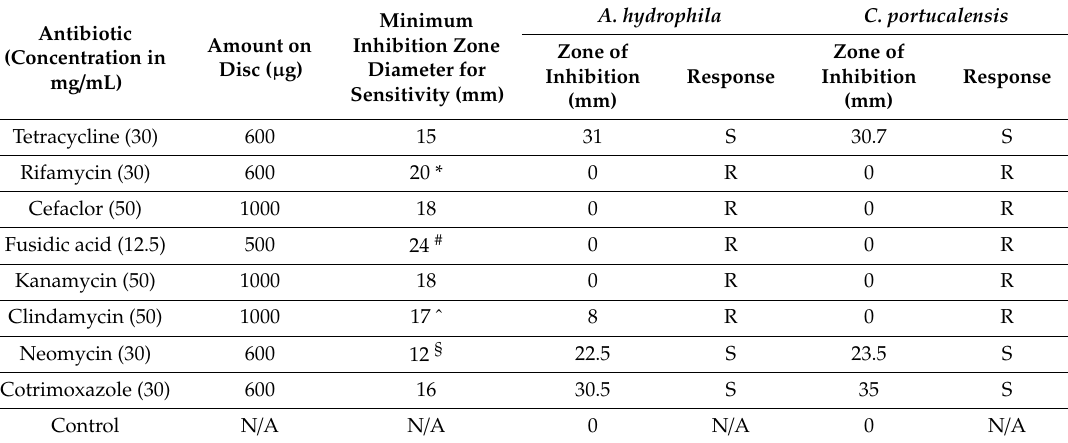
Table 2. ‘Stock concentration’ susceptibility tests using blank BD di ff usion discs spotted with stock concentrations of antibiotics for A. hydrophila and C. portucalensis grown on tryptic soy agar (TSA). The minimum zone of inhibition diameters are based on the values recommended by the CLSI for Enterobacteriaceae [81]. * denotes recommended for Rifampin by the CLSI for Enterobacter spp. # denotes EUCAST breakpoint for Staphylococcus spp. ˆ denotes EUCAST breakpoint for Streptococcus groups. § denotes EUCAST breakpoint for Enterobacterales. Cotrimoxazole = trimethoprim with sulfamethoxazole (ratio 1:5). The EUCAST numbers are taken from [81]. The responses are recorded as S = susceptible, R = resistant and I = intermediate.